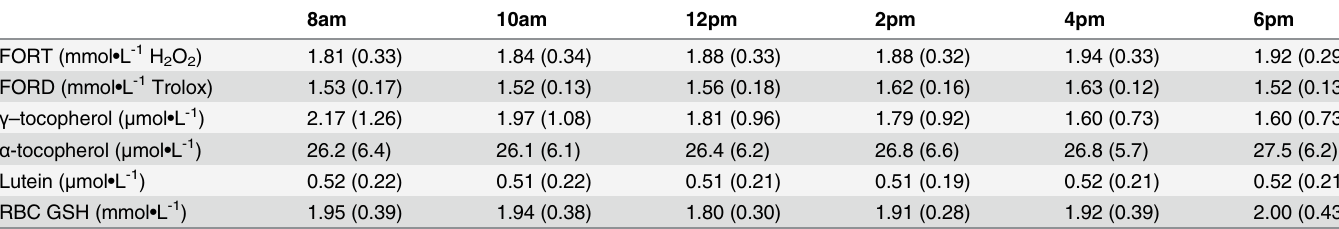
Table 1. Absolute mean ± SD concentrations for FORT, FORD, RBC GSH, lutein, and α and γ